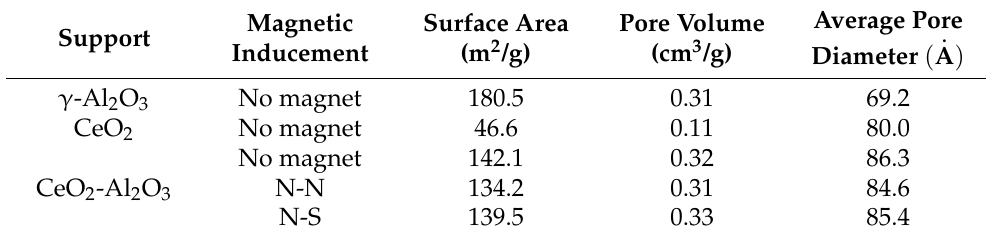
Table 2. Surface area, pore volume, and average pore diameter of γ -Al 2 O 3 and CeO 2 -Al 2 O 3 supports with and without magnetic inducement, calculated using the Brunauer, Emmett and Teller